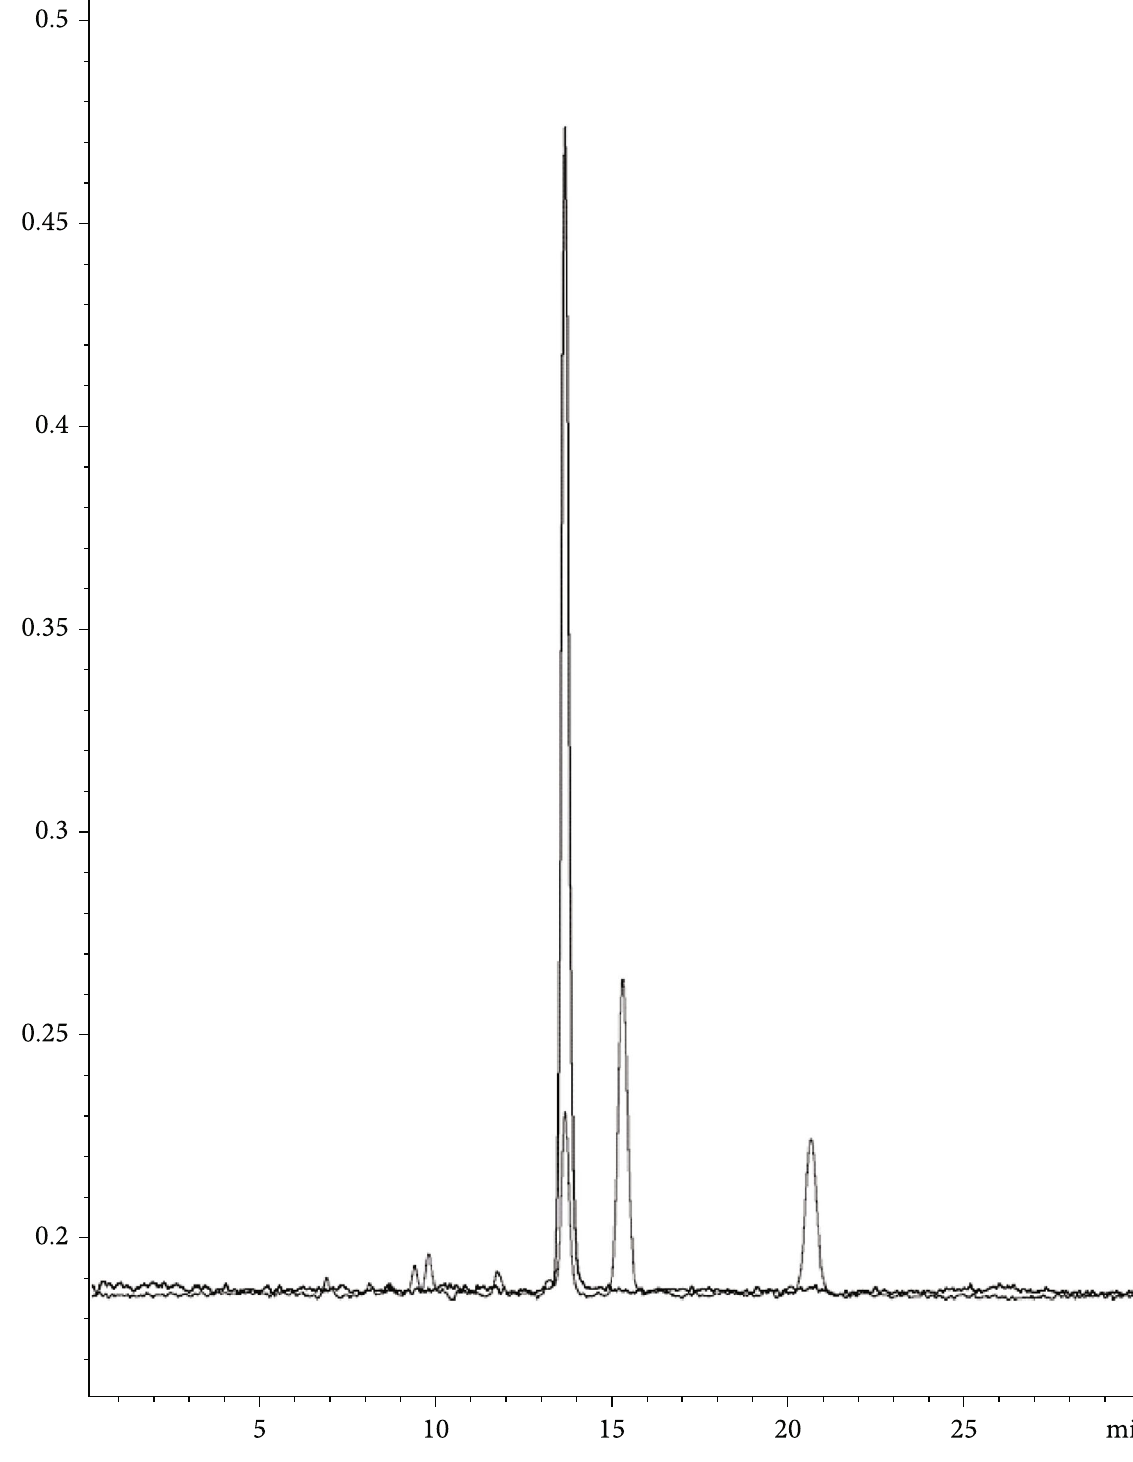
Figure 2: Superimposed LC/UV chromatograms of a levodopa standard solution (with the taller levodopa peak at 13-14 minutes) and a commercial fava bean protein isolate (with the shorter levodopa peak at 13-14